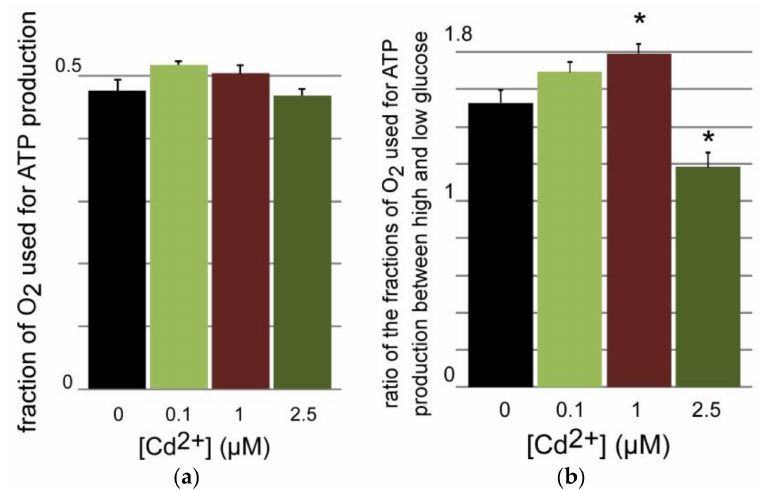
Figure 6. Respiration of INS-1 cells after 72 h-exposure to CdCl 2 . ( a ) Respiration rates were measured as described in Section 2.5 and the slope ratios [(basal – oligomycin)/basal] were calculated for each cadmium treatment group ( n = 3); ( b ) The same experiment was carried out in KRBH buffer supplemented with either 16.7 or 2.8 mM glucose ( n = 3–5). The ratio of the values obtained for each series are plotted. * One-way Anova p values of 0.013 (1 µ M) and 0.002 (2.5 µ M) as compared to the control